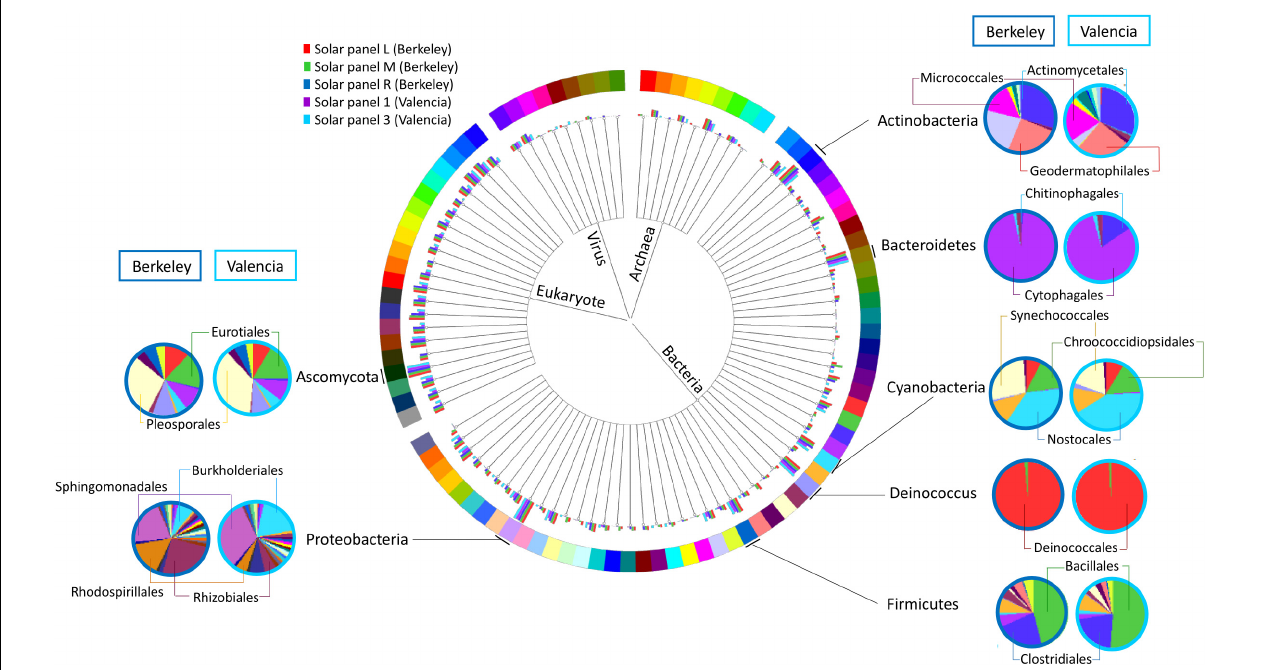
FIGURE 4 | Comparison of the taxonomic profiles of solar panels from Berkeley, CA, United States (red, green, and dark blue bars – three replicates) and Valencia, Spain (purple and light blue bars – two replicates). Most abundant taxa are indicated, and subdivisions of those taxa in one replicate from each location are represented (Berkeley and Valencia replicates in the dark and light blue circles,